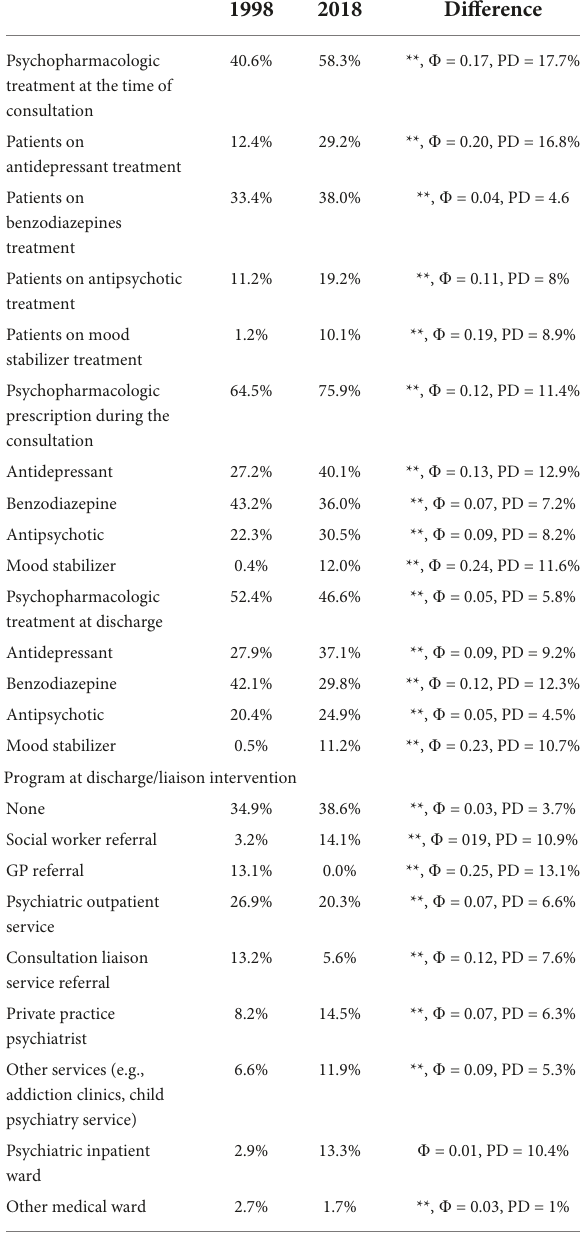
TABLE 2 Psychopharmacologic and liaison